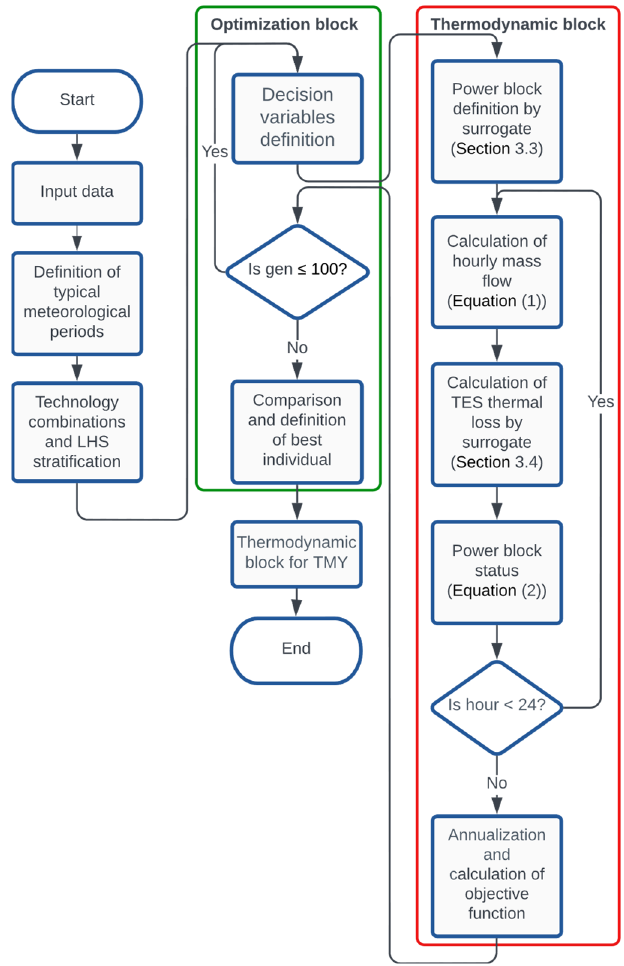
Figure 2. The algorithm flowchart for a typical day.